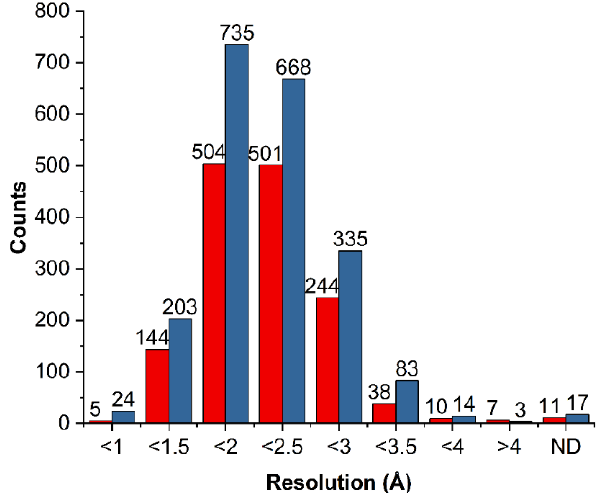
Figure 2. Statistical representation of the spectral resolution of the analyzed crystal structures deposited in the PDB database for L–R complexes with HB containing aliphatic fluorine (red bars) and aromatic fluorine (blue bars). “ND” (not determined) refers to the crystal structures obtained with the methods for which resolution was not specified (e.g., nuclear magnetic resonance).